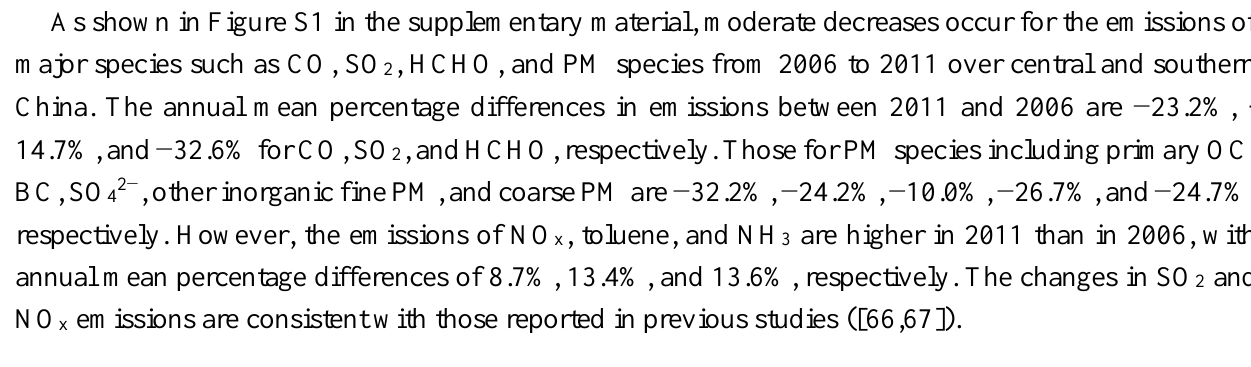
Table 6. Comparison of annual mean observed and simulated trends in meteorological variables and chemical species for 2006 and